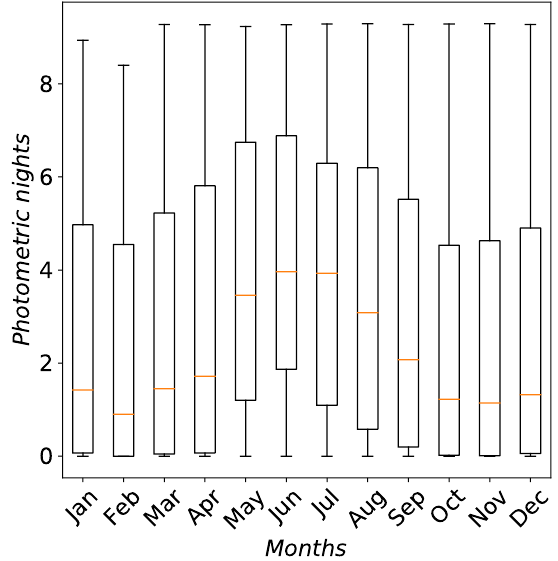
Figure 9. Box and whisker plots for photometric nights during 2010–2021 at the BTA site. The central horizontal lines inside the boxes are medians; bottoms and tops of the boxes are standard deviations; and ends of the whiskers are the minimum and maximum values.